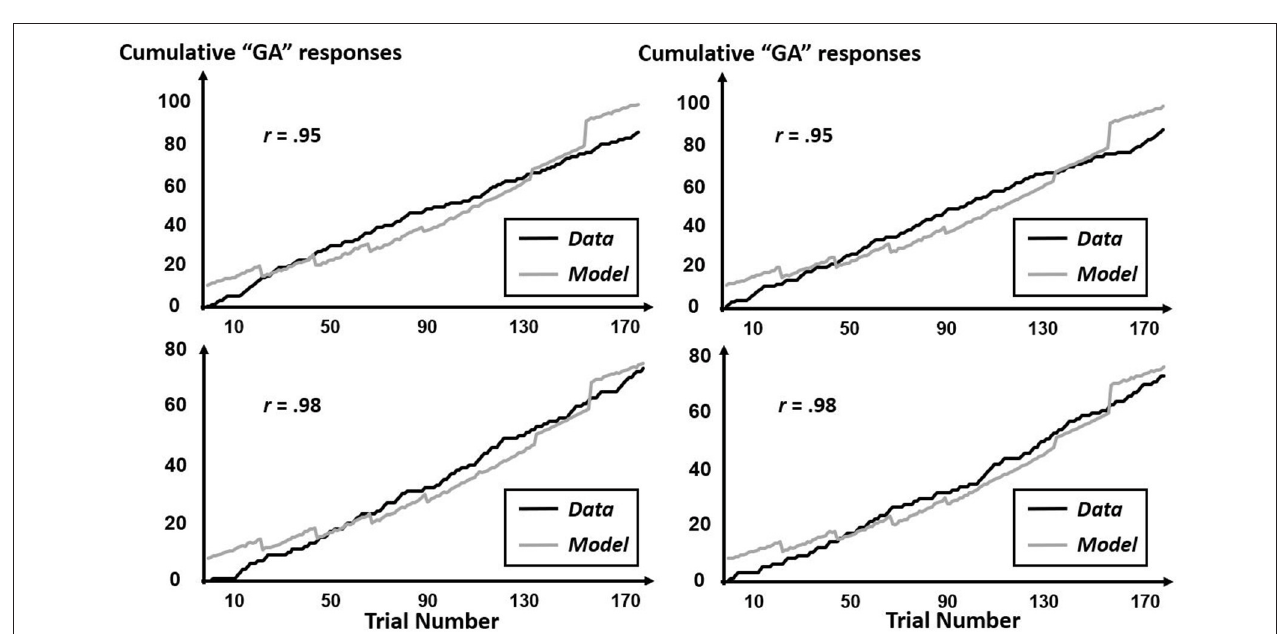
FIGURE 7 | Cumulative “GA” judgments and corresponding model predictions for four individual participants in the real-speech context. To depict the full range of regression-model performance in the real-speech condition, we include individual-participant plots from the two participants for whose data the model fit worst (top two panels) as well as from the two participants for whose data the model fit best (bottom two panels).